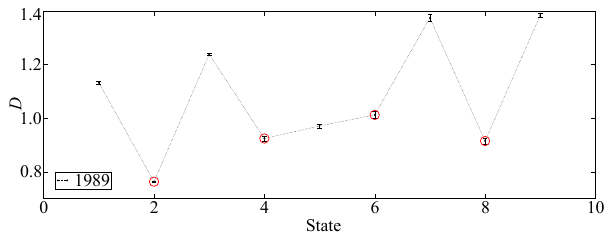
Figure 3. Box-counting dimension D for storm and quiet states for the year 1989. Labels in the horizontal axis represent consecutive states as mentioned in Sect. 3. Storm states are marked with red circles, whereas errors are taken from the least-squares linear fit. (Taken from Domínguez et al.,